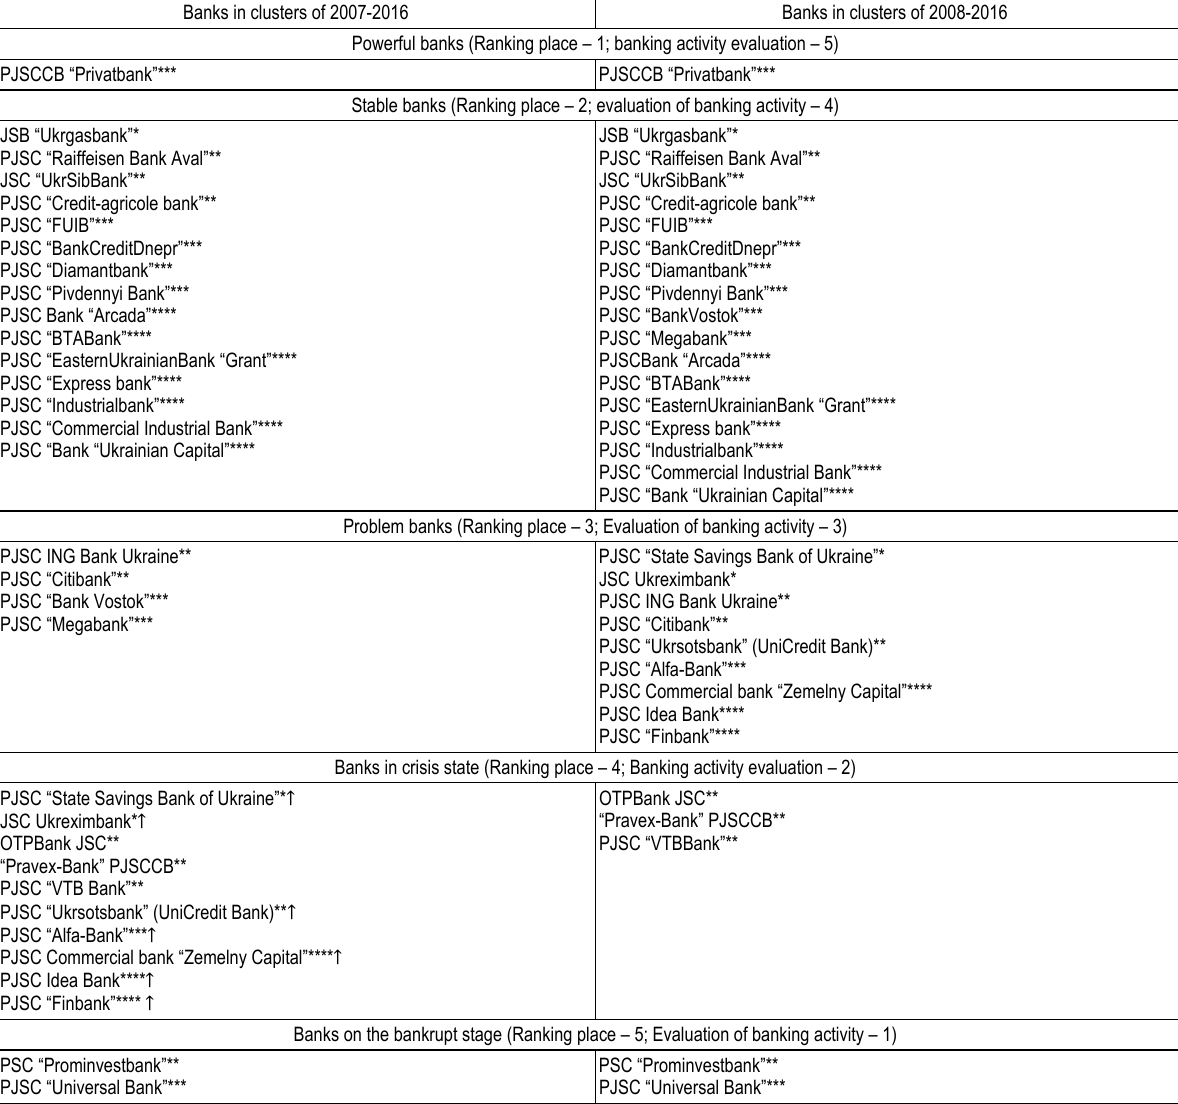
Table 5. Banks placement in